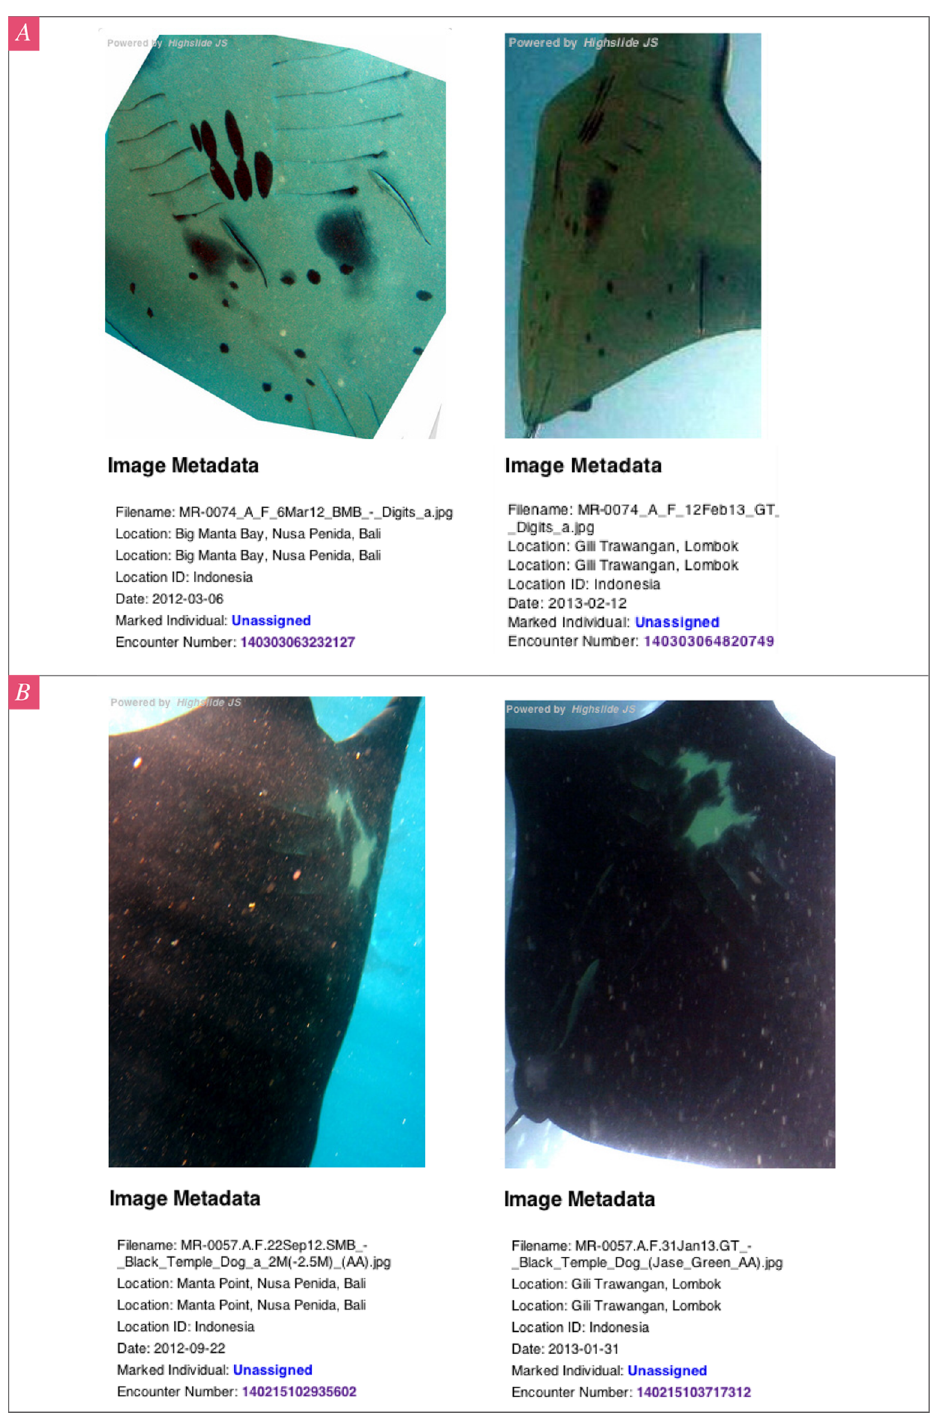
Figure 4. Screen grabs of photographs uploaded to the ‘Manta Matcher’ online database documenting M.alfredi movements from Nusa Penida (NP), Bali to Gili Islands (GI), Lombok. A. Manta ID code INNLP0074A. B. Manta ID code INNLP0057A.